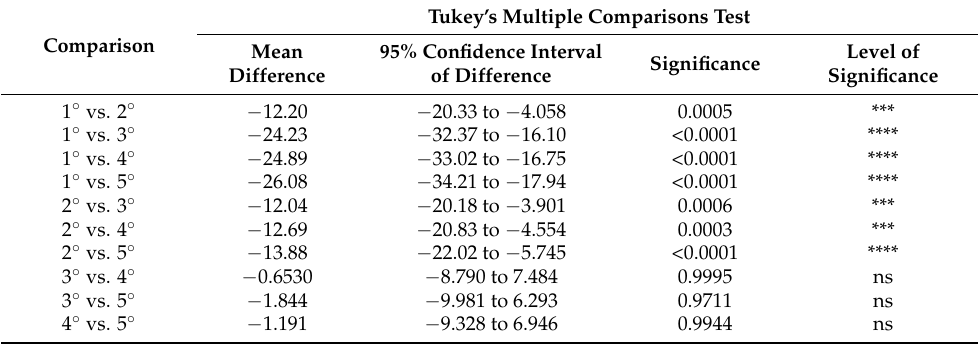
Table 2. Post-hoc Tukey’s multiple comparison tests performed for investigate change between